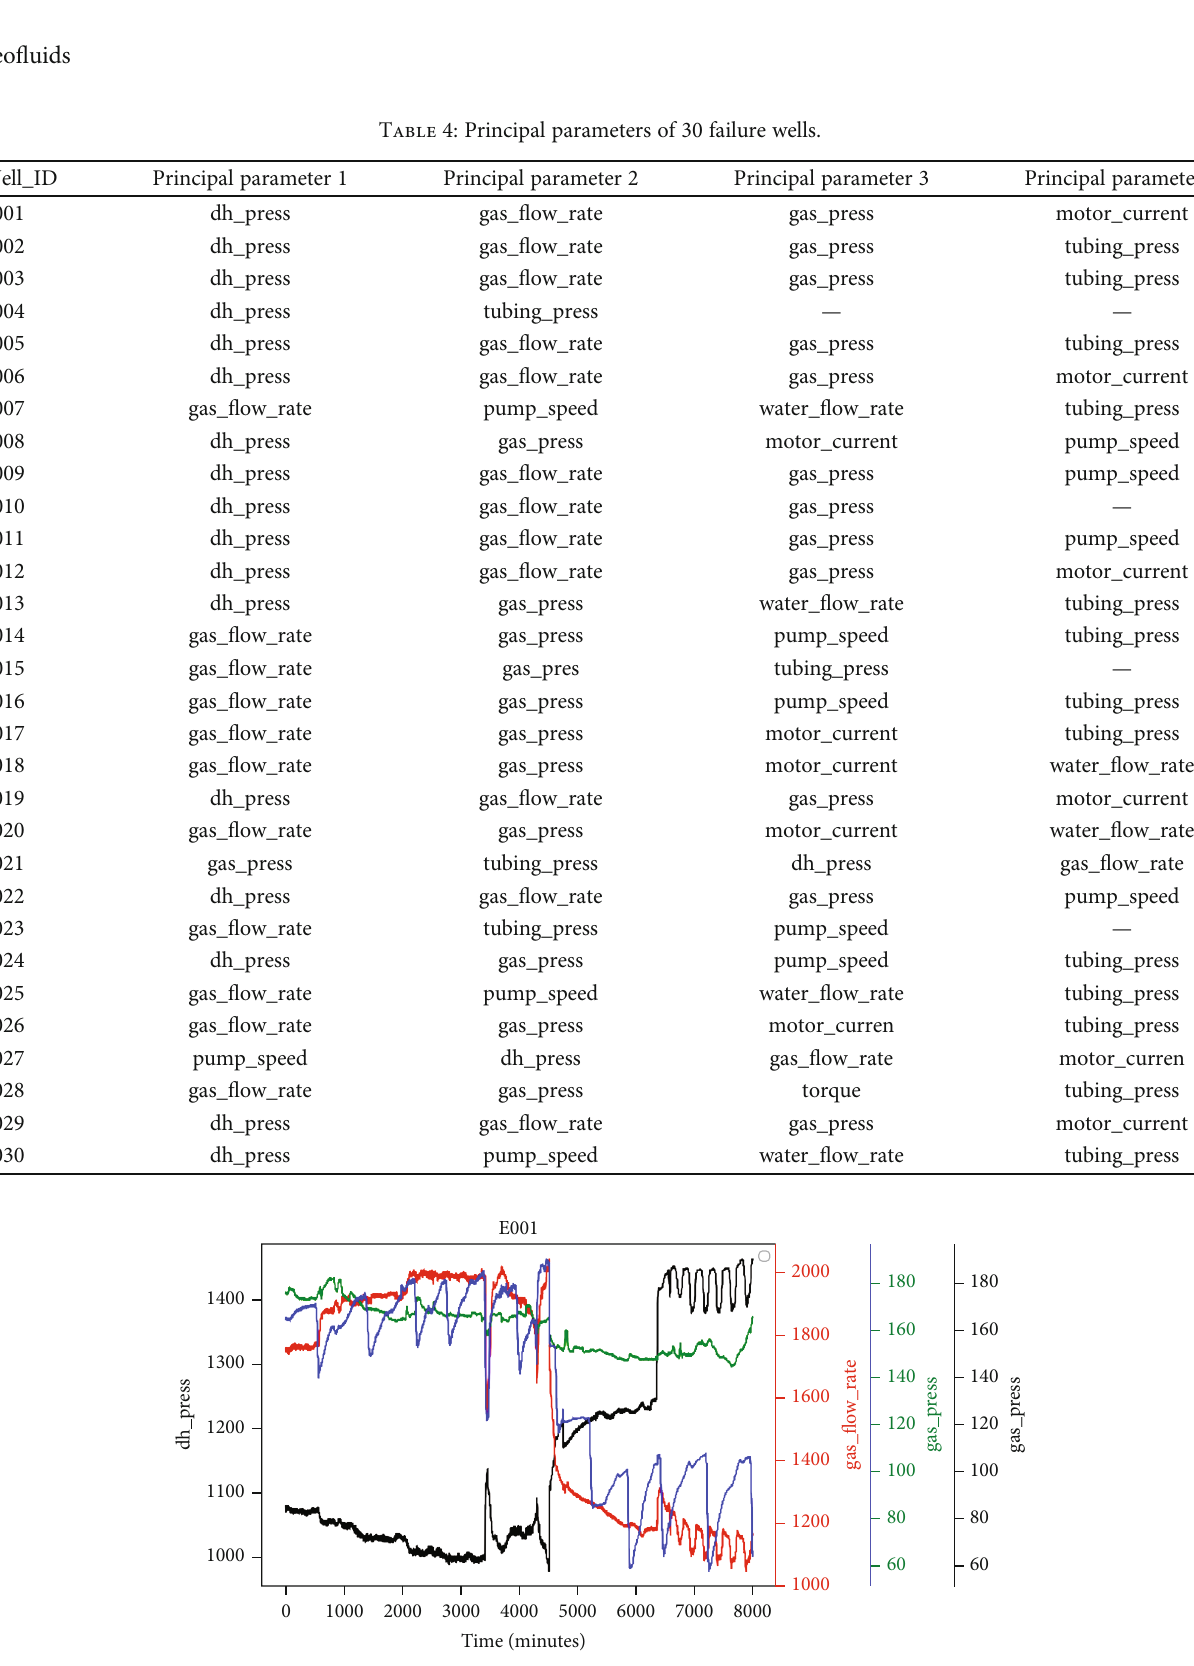
Figure 5: Four principal parameters of